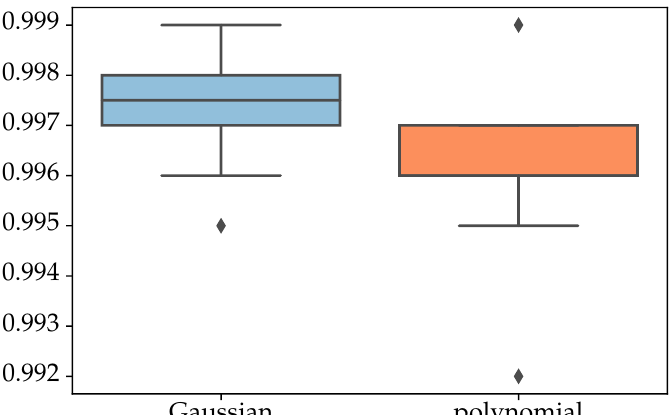
Figure 8. Support Vector Machine (SVM Gaussian and second-degree polynomial kernel function accuracy scores after 10-fold cross-validation.